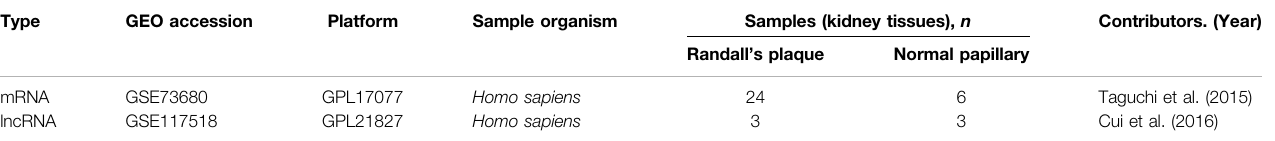
TABLE 1 | Details of lncRNA and mRNA datasets of patients with calcium oxalate kidney